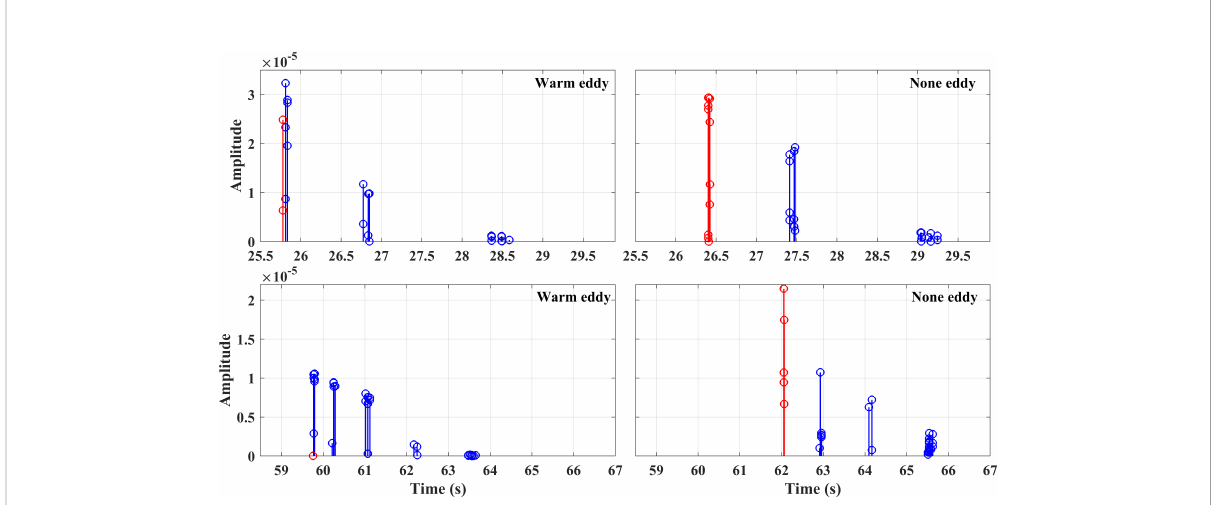
FIGURE 8 Arrivals from the sound source at 185 m depth and 0 km distance to the receiver at 200 m depth and 39 km (upper panel) and 92 km (lower panel) distances with warm eddy (left panel) and none eddy (right panel)